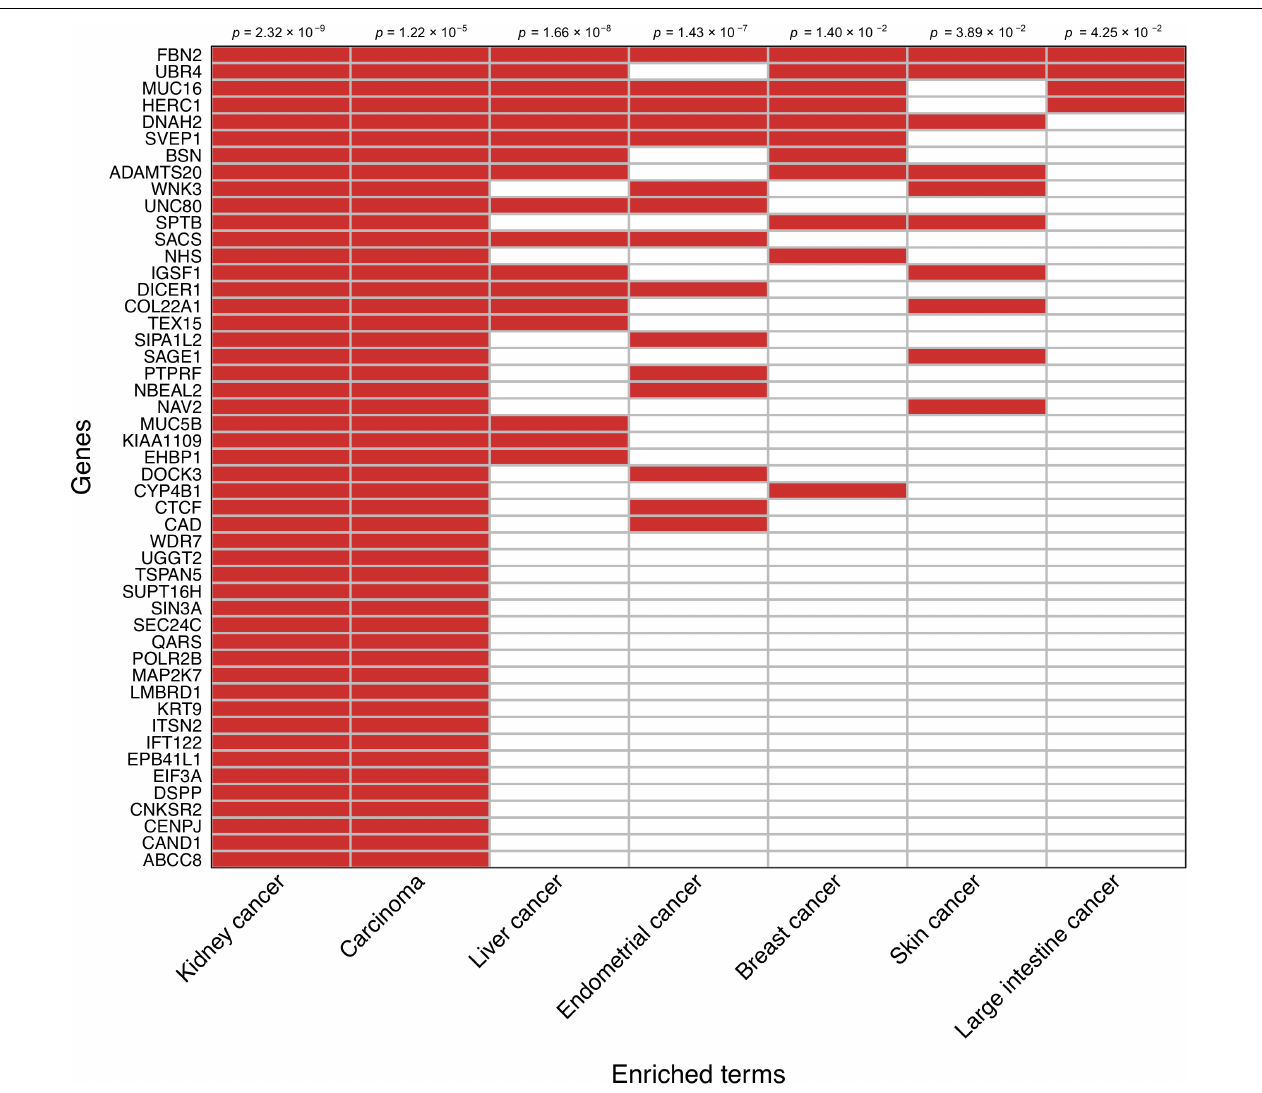
FIGURE 3 | Clustergram representing the association of the subset of 49 prioritized genes that have direct links with kidney cancer. Relationships with other cancer types are also shown. Significance values are shown on the top.